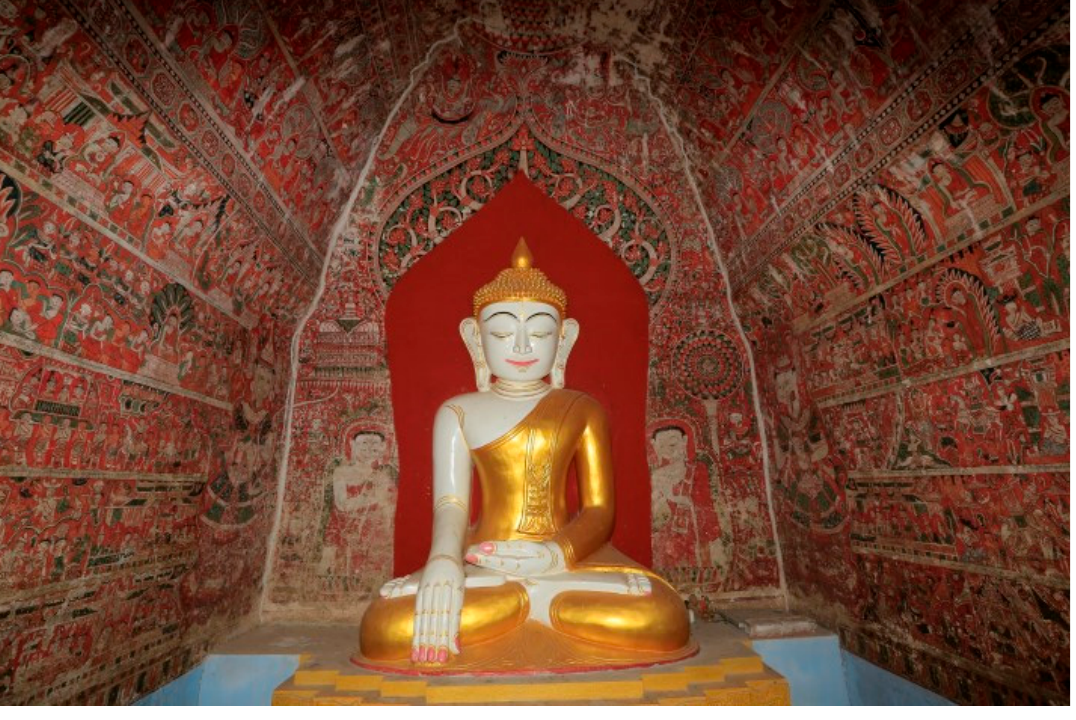
Figure 12. Salyingyi, 18th century, interior.